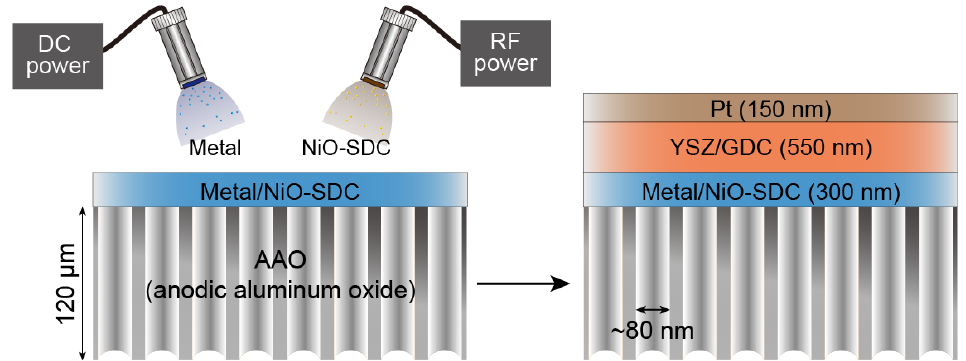
Figure 1. Schematic of the fabricated cell configuration. The membrane-electrode assembly (MEA) on the anodic aluminum oxide (AAO) consists of 300-nm-thick metal / NiO-SDC anode, 550-nm-thick YSZ / GDC bi-electrolyte, and 150-nm-thick Pt cathode.